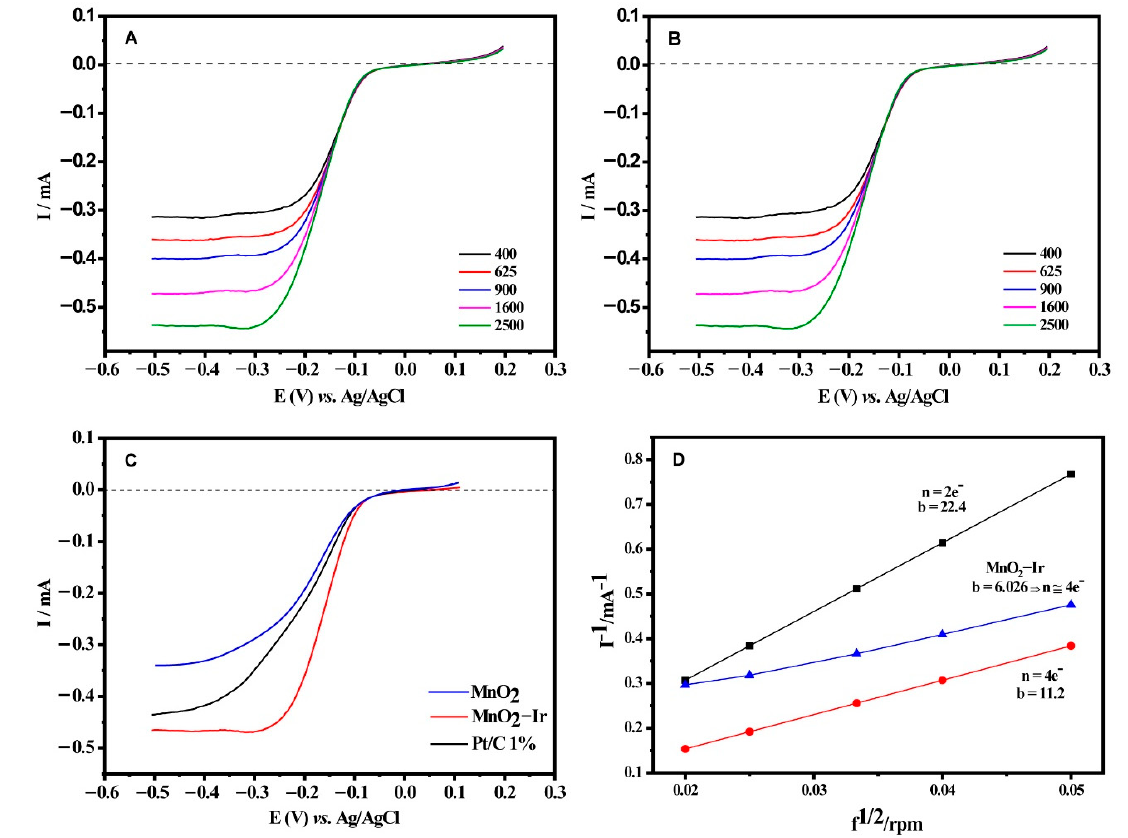
Figure 6. LSVs for the MnO 2 nanowires ( A ) and MnO 2 -Ir electrocatalyst ( B ) in 0.1 mol L − 1 KOH solution saturated with O 2 , v = 5 mV s − 1 . ( C ) Polarization curves for the ORR on MnO 2 , MnO 2 -Ir, and 1.2 wt.% Pt/C materials, in 0.1 mol L − 1 KOH solution, f = 1600 rpm, v = 5 mV s − 1 , room temperature. ( D ) Koutecky - Levich graphs for the oxygen reduction reaction on MnO 2 -Ir and MnO 2 , in 0.1 mol L − 1 KOH solution, at different electrode rotation speeds, v = 5 mV s − 1 , room